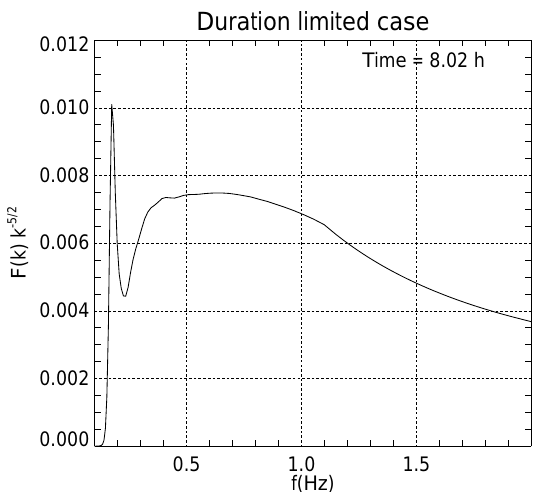
Figure 8. Compensated spectrum as the function of linear frequency f for the wind speed U = 10ms − 1 duration limited case.